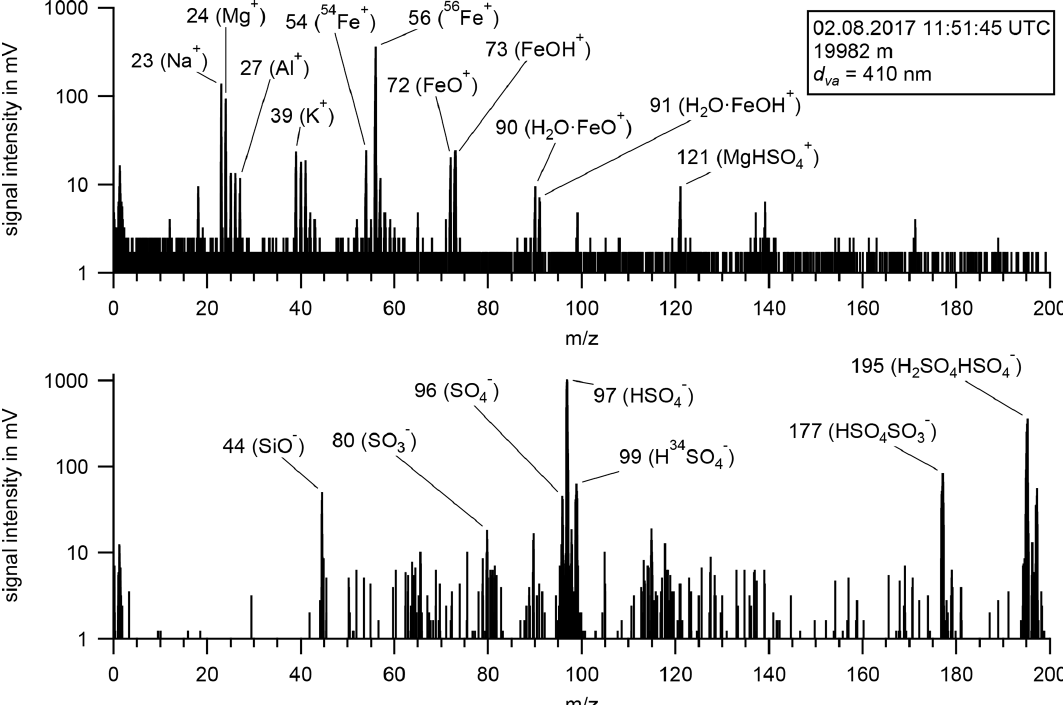
Figure 10. Raw bipolar spectrum of an atmospheric single particle containing meteoric material, sampled at 19982m (barometric altitude, coordinates: 28.6428 ◦ N, 82.9307 ◦ E) during StratoClim 2017 (flight KTM 4, 2 August 2017, 11:51:45UTC; d va = 410nm).